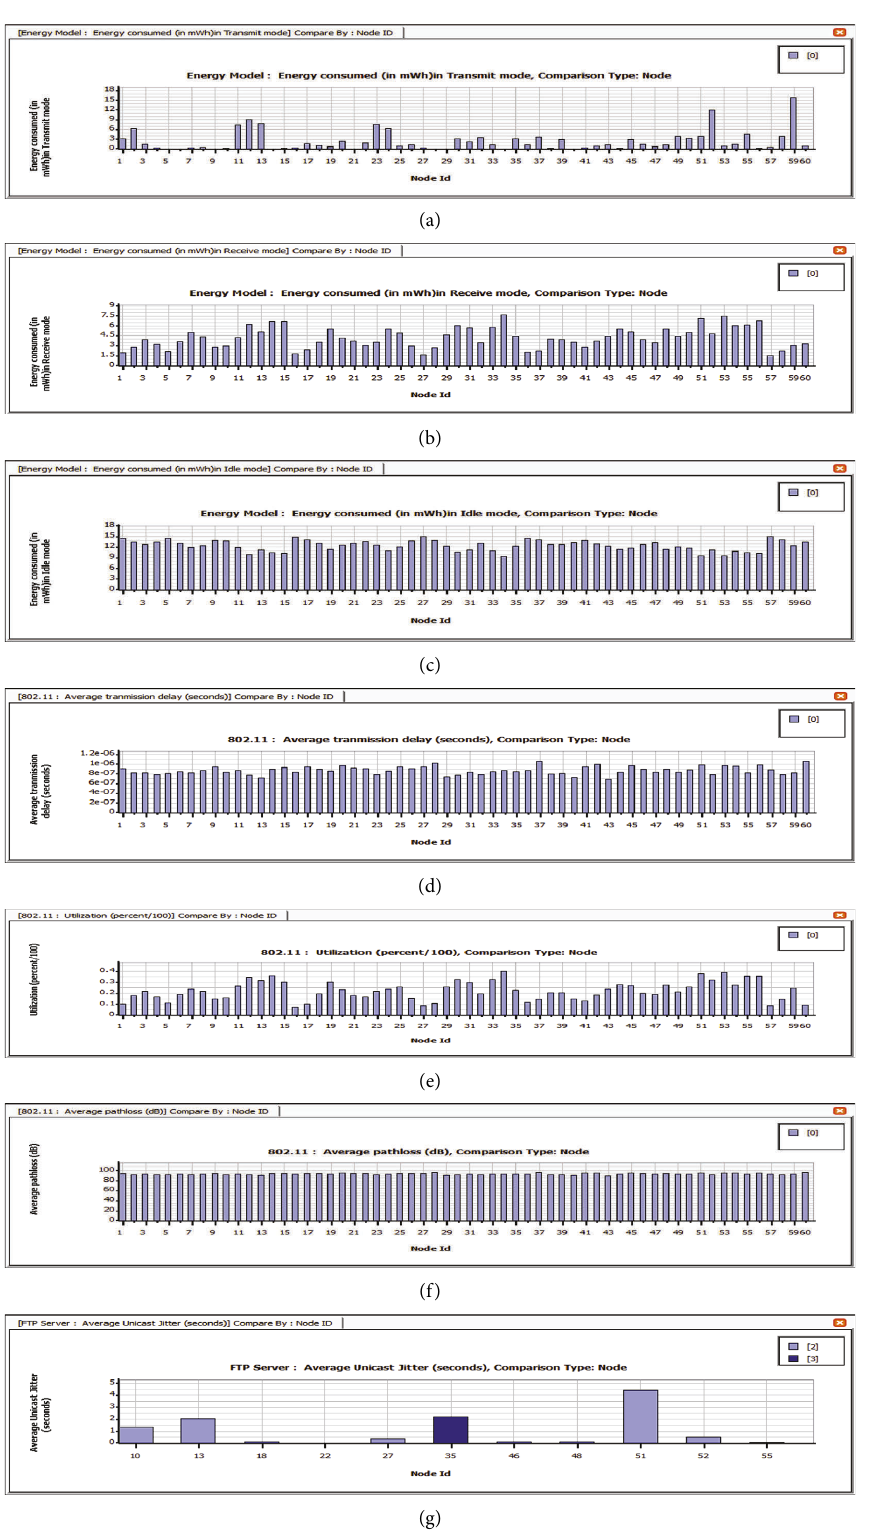
Figure 8: (a) Transmit mode energy consumption of AODV for FTP deployment. (b) Receive mode energy consumption of AODV for FTP deployment. (c) Idle mode energy consumption of AODV for FTP deployment. (d) Average transmission delay of AODV for FTP deployment. (e) Percentage of utilization of AODV for FTP deployment. (f) Average pathloss of AODV for FTP deployment. (g) Average unicast jitter of AODV for FTP